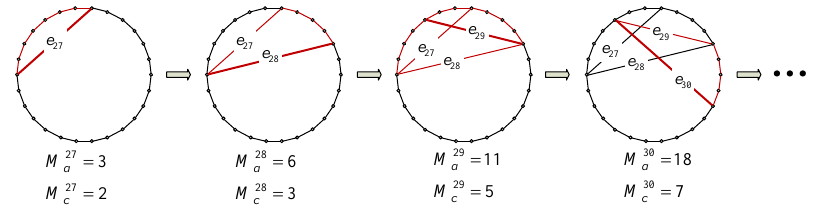
Figure 3. The process of progressive chord edge growth and related cycles. M 27 a , M 28 a , · · · , M 52 a represent the total number of cycles, and M 27 c , M 28 c , · · · , M 52 c represent the number of the cycles that are introduced by the newly added chord